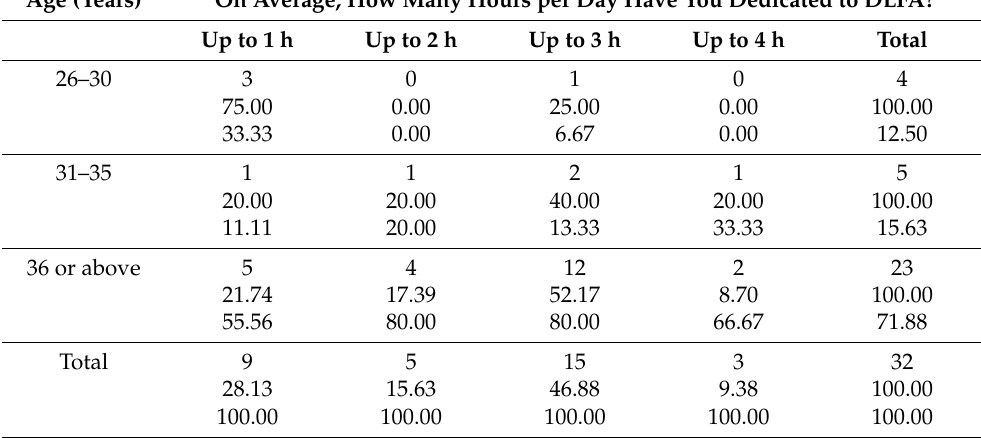
Table 3. Analysis of age by average hours per day dedicated to distance learning of financial accounting